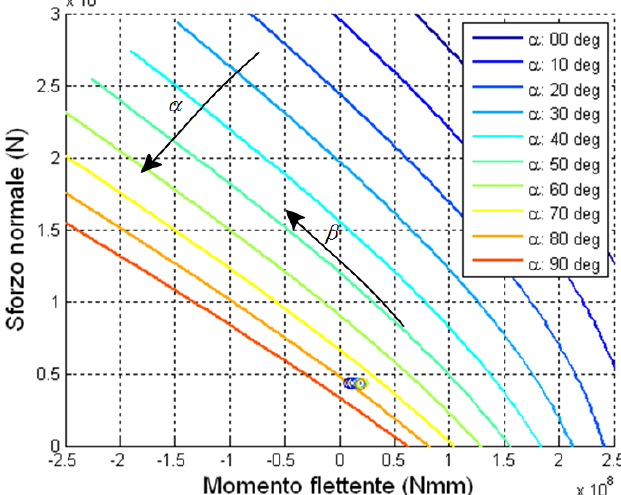
Figura 13: Relazione tra sforzo normale e momento flettente al collasso e sollecitazioni